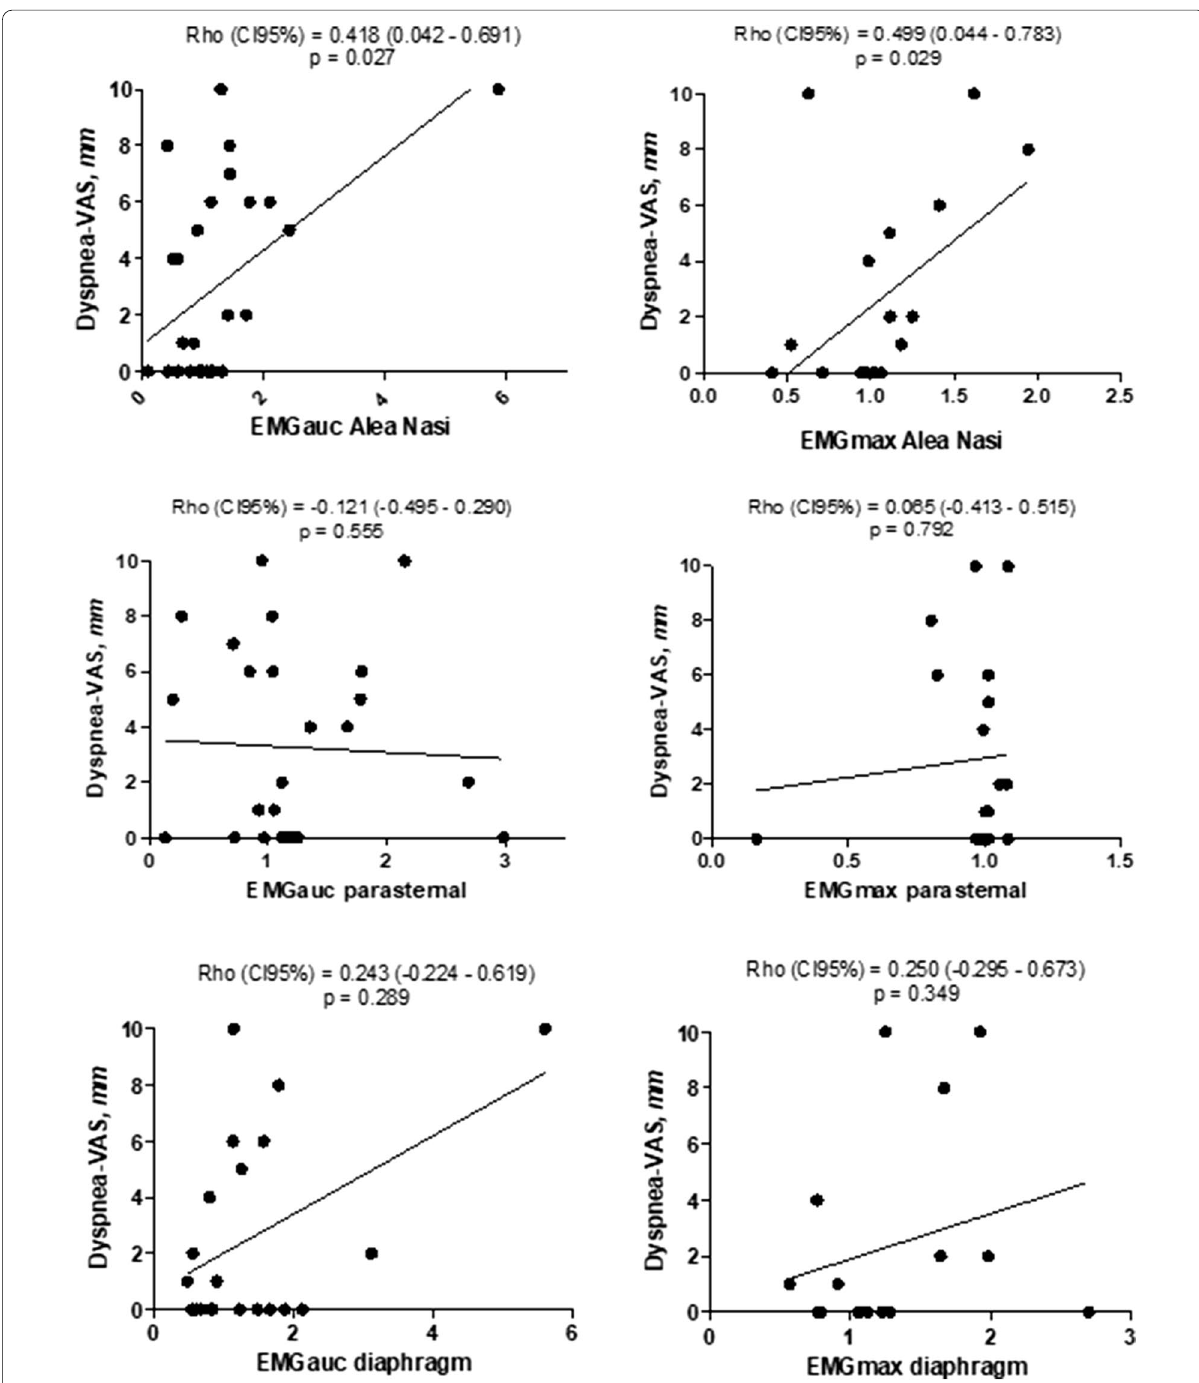
Fig. 2 Correlation between the change of Dyspnea-Visual Analog Scale (VAS) and the change in electromyographic (EMG) activity of the Alae nasi , parasternal intercostal muscles and diaphragm between the initiation and end of the spontaneous breathing trial. Change in dyspnea-VAS is expressed as the difference between dyspnea-VAS at the initiation and end of the spontaneous breathing trial. The EMG activity is described by area under the curve (EMGauc) and maximum (EMGmax). Values are normalized to EMG activity at initiation of the SBT and are expressed as the ratio of the EMG activity at the end of the SBT to the EMG activity at the initiation of the